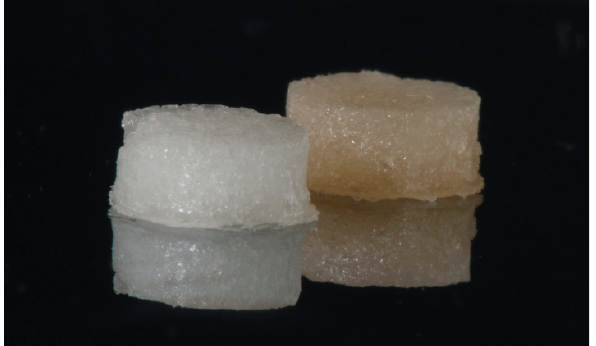
Figure 5. Visible-light photopolymerized NCHGs, the white does not contain drugs, and yellowish shows the CHX and Metr-filled hydrogel.